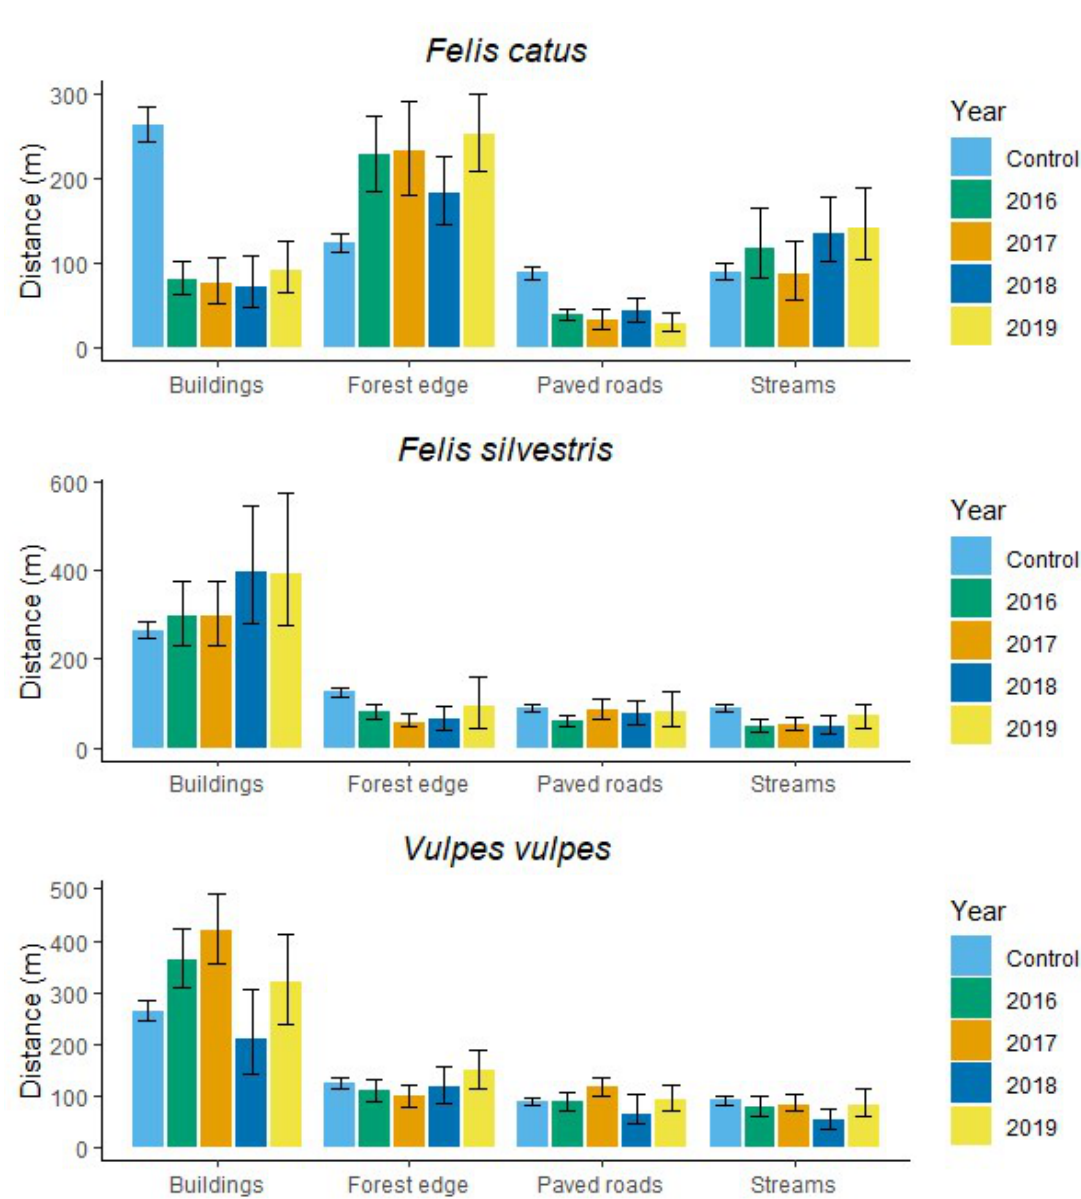
Figure 2. Distance of observed domestic cats, European wildcats, and red foxes to di ff erent Figure 2. The regional meteoric water line of the coastal part of Croatia (RMWL_coast) and the stable environmental features in pastures for each study year compared to the distance from random isotope composition of the spring water in the Dinaric karst in Croatia: ( a ) the mean values of the stable points to these same environmental features (Control). Error bars represent 95% isotopes and ( b ) the single values of the stable isotopes.